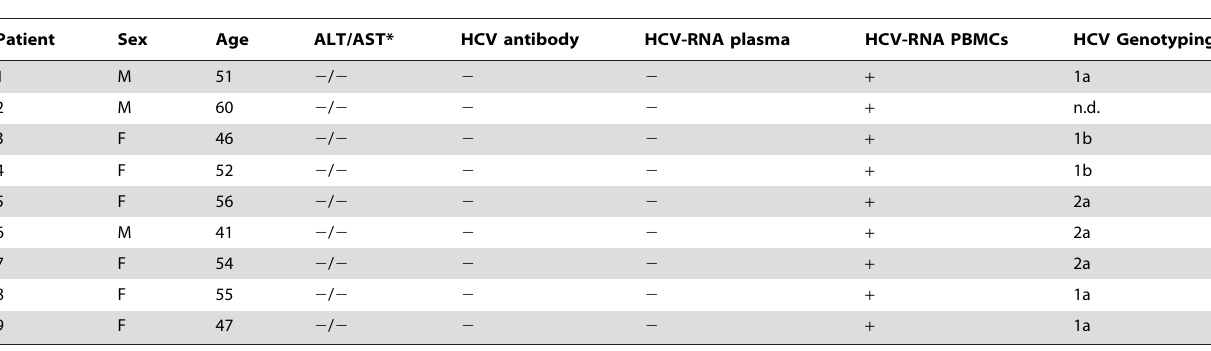
Table 2. Characteristic of subjects showing occult